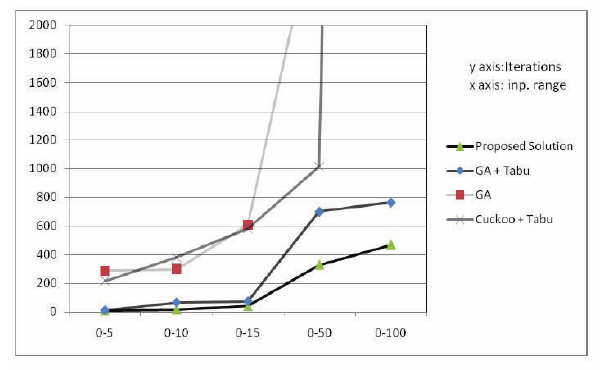
Figure 9. Comparison of results.